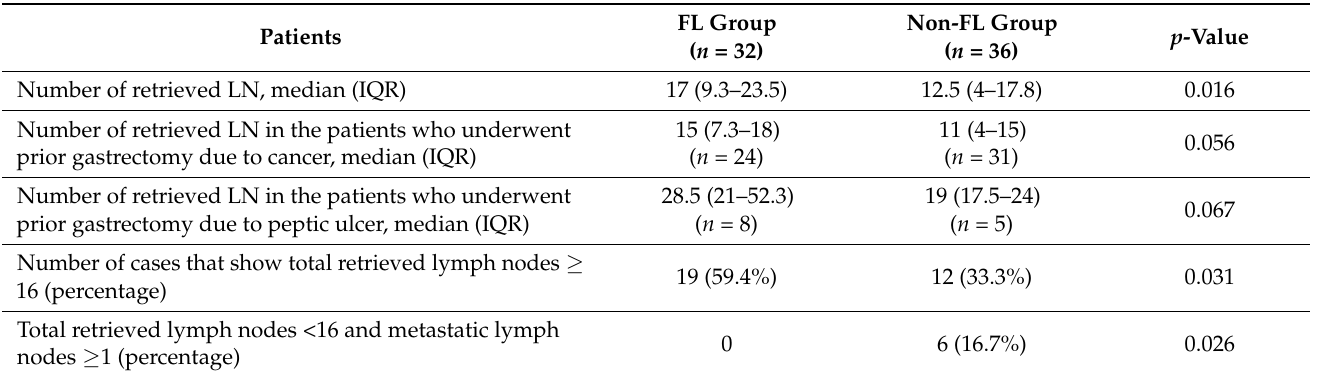
Table 3. Comparison of retrieved lymph